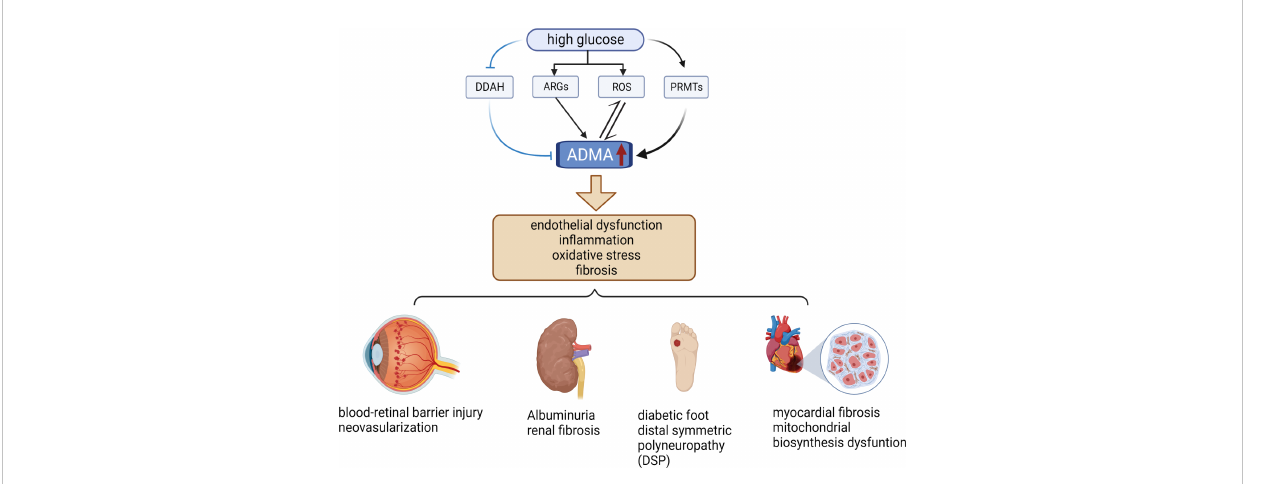
FIGURE 2 Relationship between ADMA and diabetic microvascular complications. High levels of glucose increase the level of ARGs, ROS, and PRMTs while decreasing the level of DDAH, resulting in elevated levels of ADMA. Elevated levels of ADMA can stimulate even more ROS production and further increase ADMA levels. Elevated ADMA induces endothelial dysfunction, in fl ammation, oxidative stress, and fi brosis. These pathological changes cause several diabetic microvascular complications, such as DR, DN, DF, DSP, and DCM. (The fi gure was created with